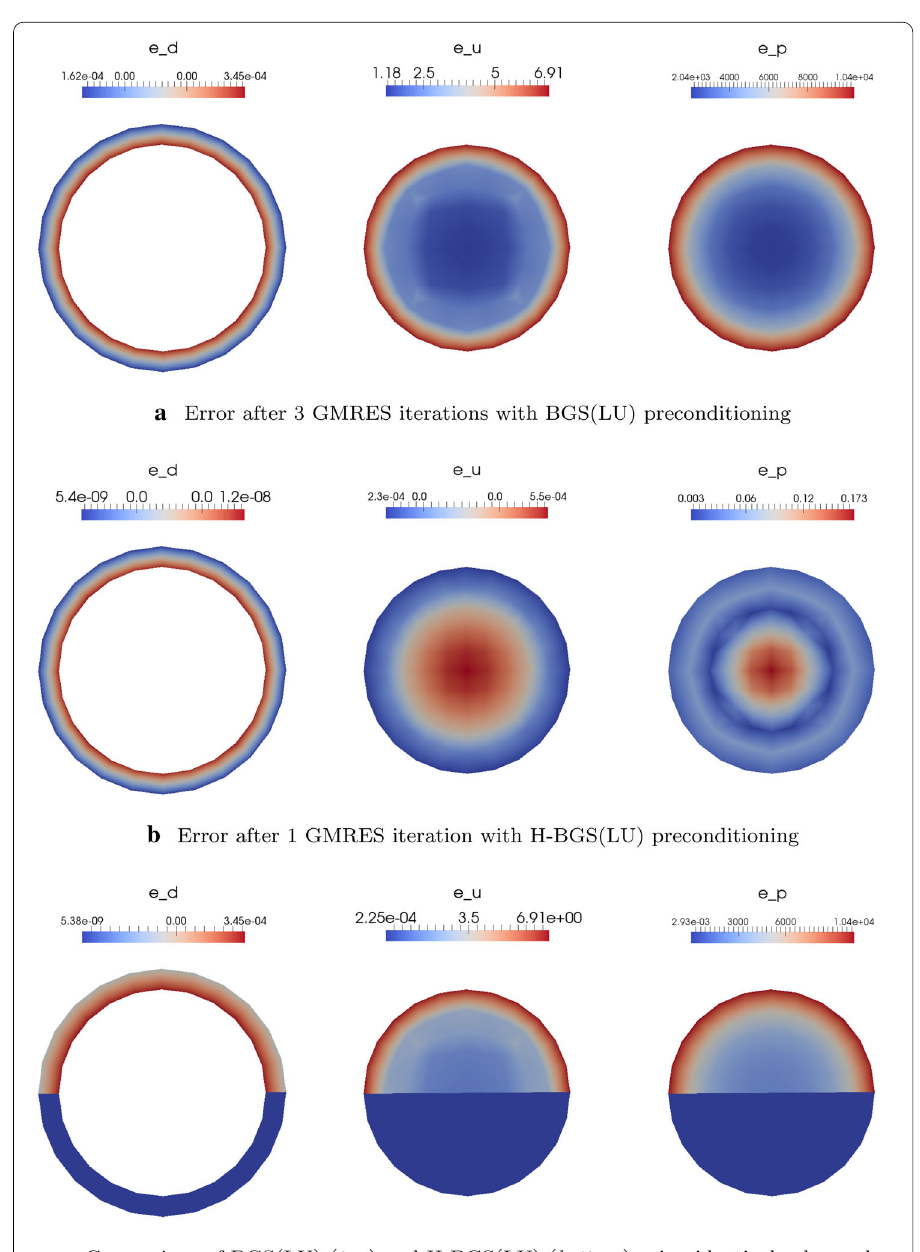
Fig. 5 Comparison of the error distribution in case of BGS(LU) and H-BGS(LU)—errors in solid displacements, fluid velocities, and fluid pressures denoted by e_d, e_u, and e_p, respectively, are visualized on a cross section of the pressure wave